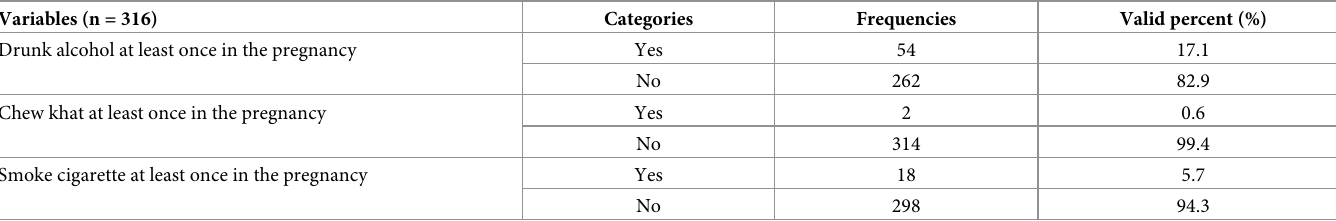
Table 4. Substance use among pregnant women attending public health facilities in Arba Minch SNNPR Ethiopia 2018.